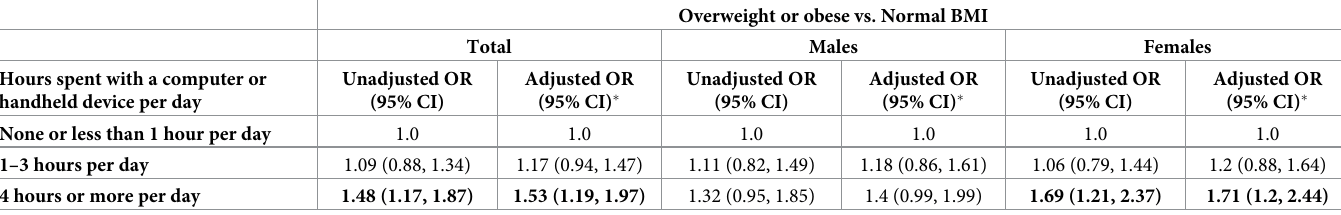
Table 3. Results of logistic regression analysis of the association between time spent with computers, cell phones, handheld video games and other electronic devices, and BMI in adolescents. Overweight or obese vs. Normal BMI Total Males